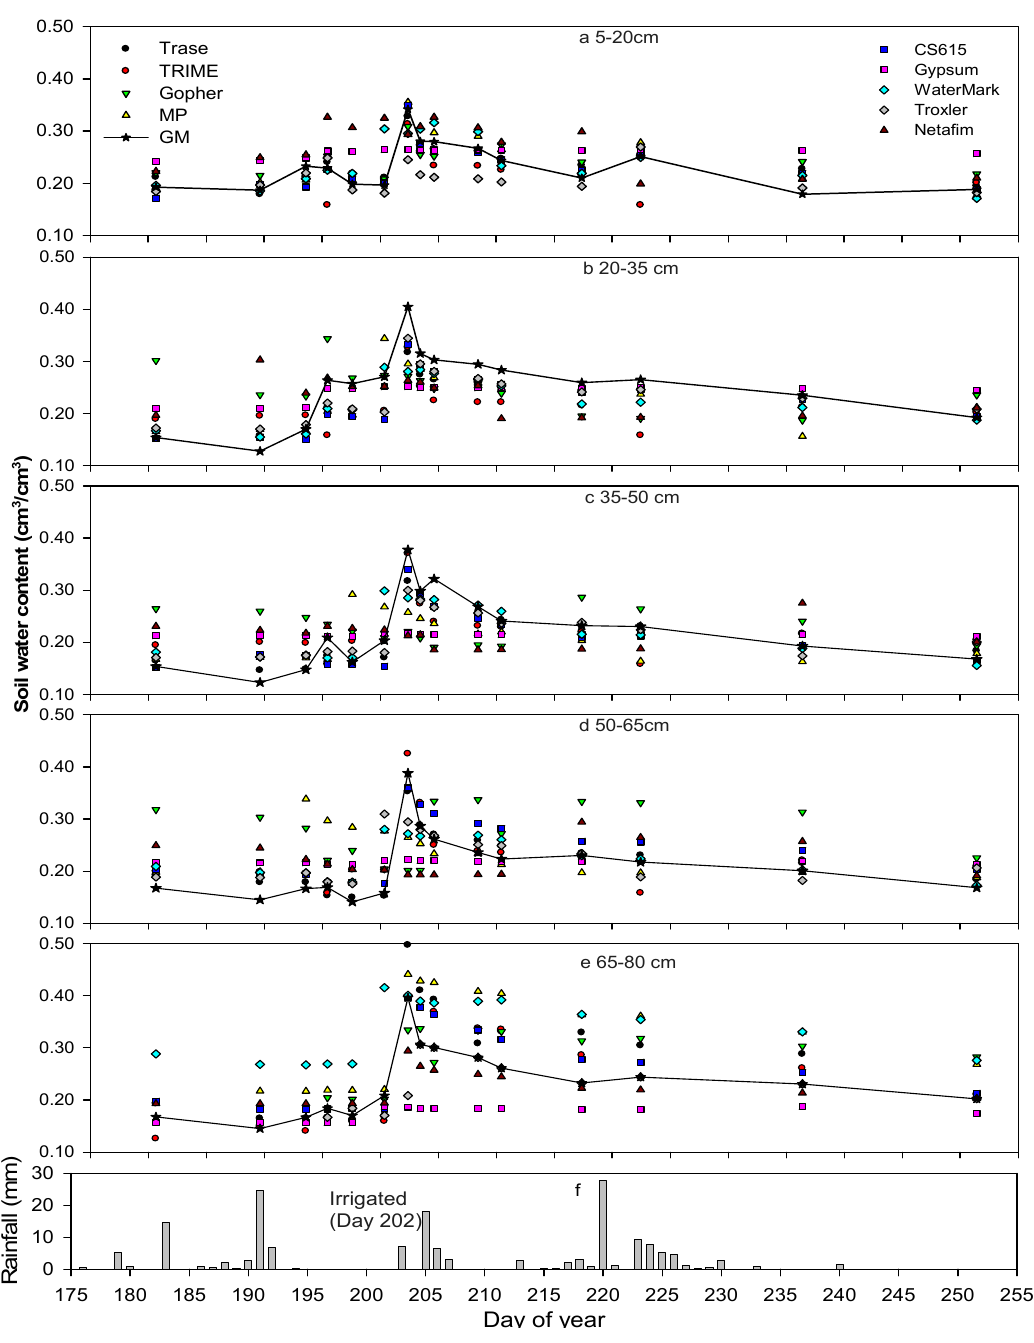
Figure 4. Time series of water contents obtained by different measurement methods as a function of soil